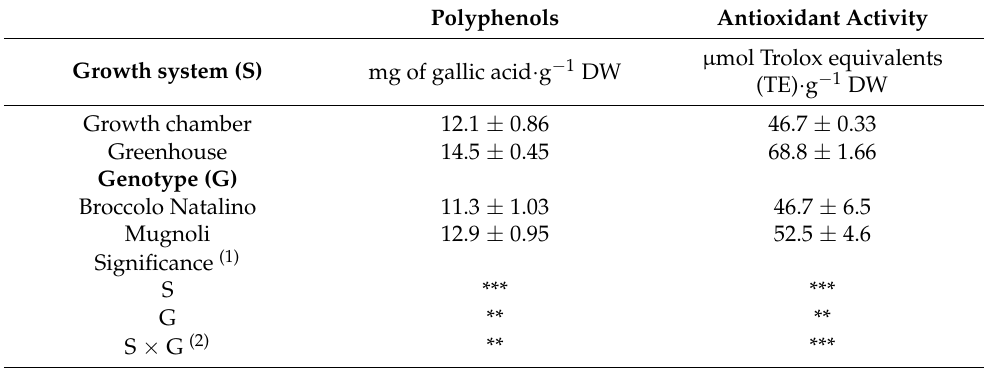
Figure 8. Antioxidant activity, expressed as µ mol Trolox equivalents (TE) · g − 1 of DW, of Mugnoli and Broccolo Natalino microgreens grown in a growth chamber under CTRL, CTRL + B, and B artificial light treatments. Vertical bars represent ± standard deviation of mean values. Letters on the columns indicate significant differences according to Student–Newman–Keuls (SNK) test at p = 0.05. Table 6. Polyphenols content and antioxidant activity, expressed as dry weight (DW), of two brassica microgreens (Broccolo Natalino and Mugnoli) cultivated in a growth chamber and in a greenhouse with sunlight. Means followed by different letters within a column indicate significant differences according to Student–Newman–Keuls (SNK) test at p =